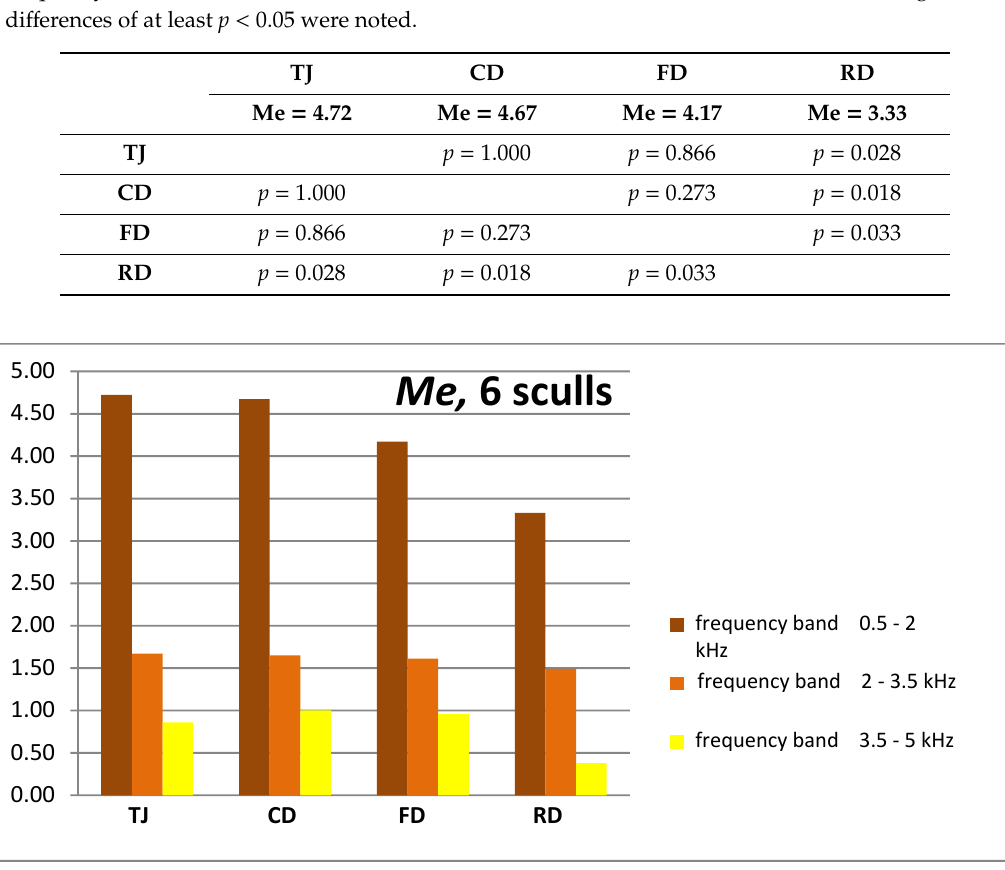
Figure 5. Me—comparison of e ff ective vibration velocity vRMS (mm / s) measured on the l and r side of 6 skulls in the 1.5 kHz bands. Four states of dentition (column